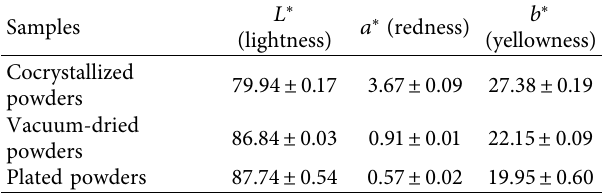
Table 3: Total phenolic and favonoid contents of moringa leaves extract, moringa leaves, and moringa leaves extract